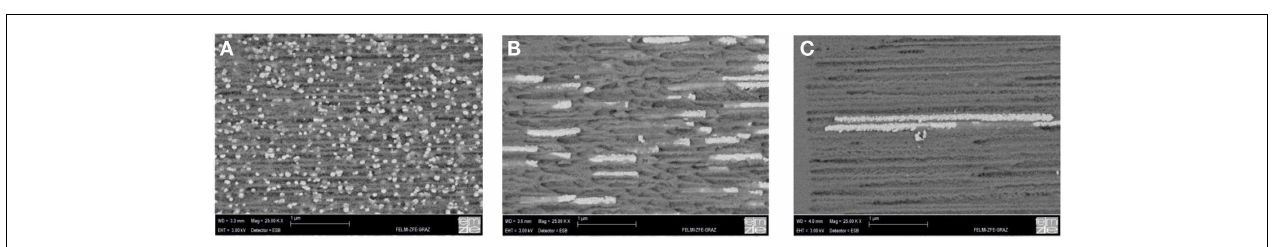
FIGURE 2 | (A) Deposited Ni-particles of about 60nm in diameter. (B) Ellipsoidal Ni-structures of about 500nm in length. (C) Ni-wires of about 4 µ m in length. The diameter of all structures coincides with the pore-diameter